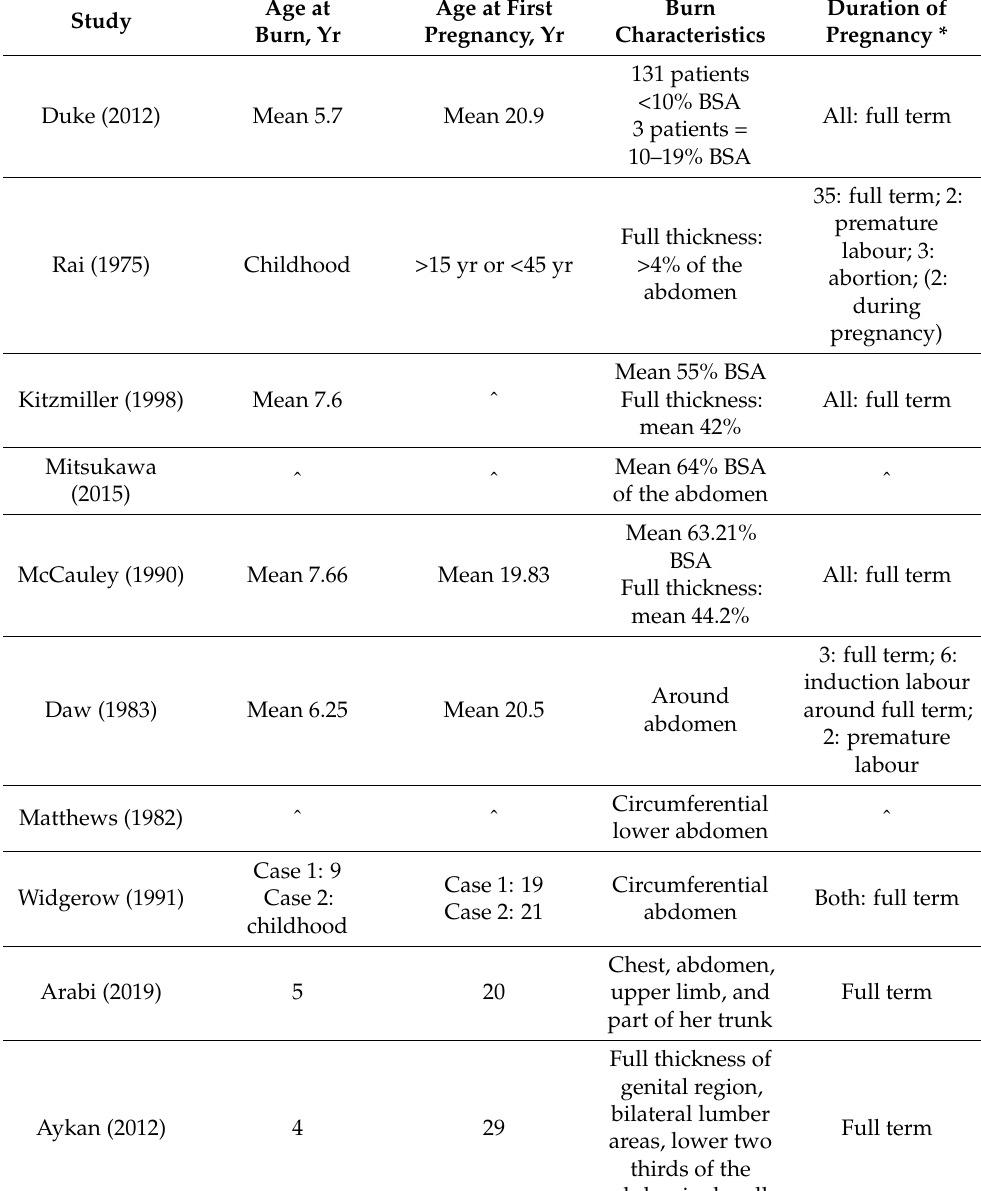
Table 2. Overview of patient